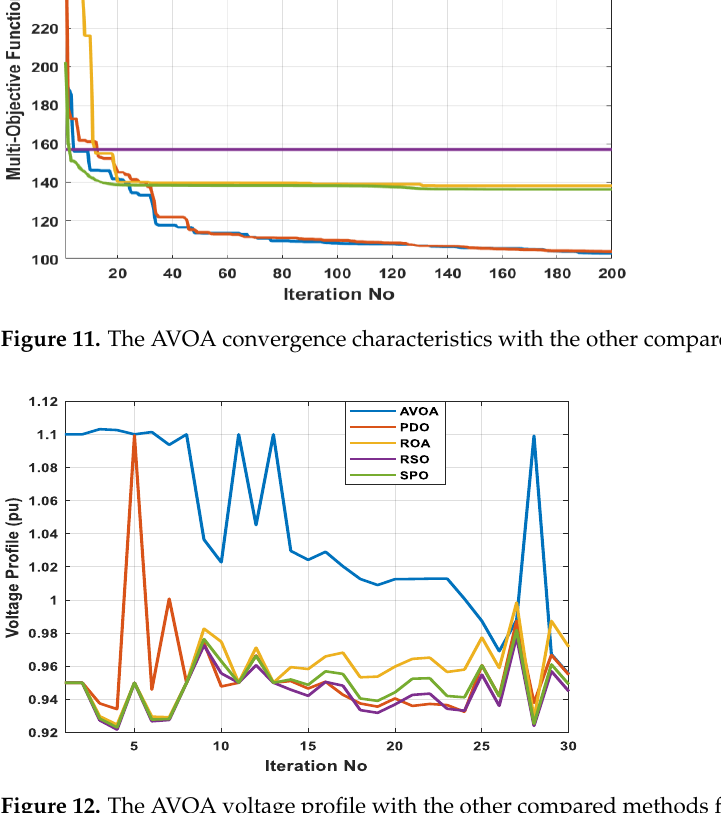
Figure 12. The AVOA voltage profile with the other compared methods for case 5.